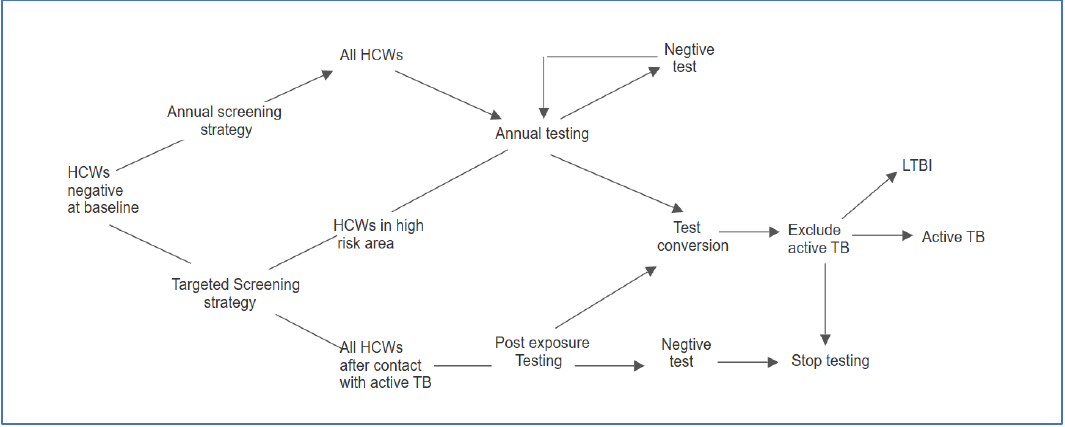
Figure 1. Representation of the two screening strategies. HCWs: healthcare workers, TB: tuberculosis, LTBI: latent TB infection.